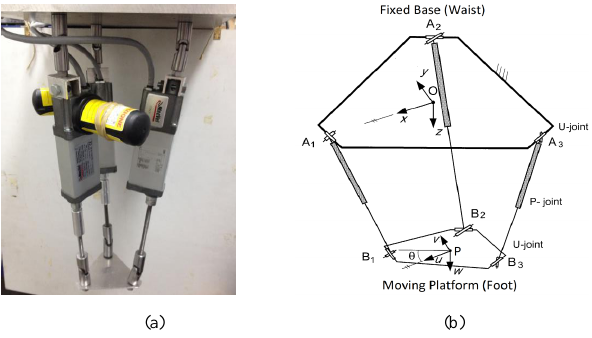
Figure 1. A design of LARM tripod leg mechanism: (a) a prototype at LARM; (b) a kinematic scheme of 3-UPU parallel manipulator.